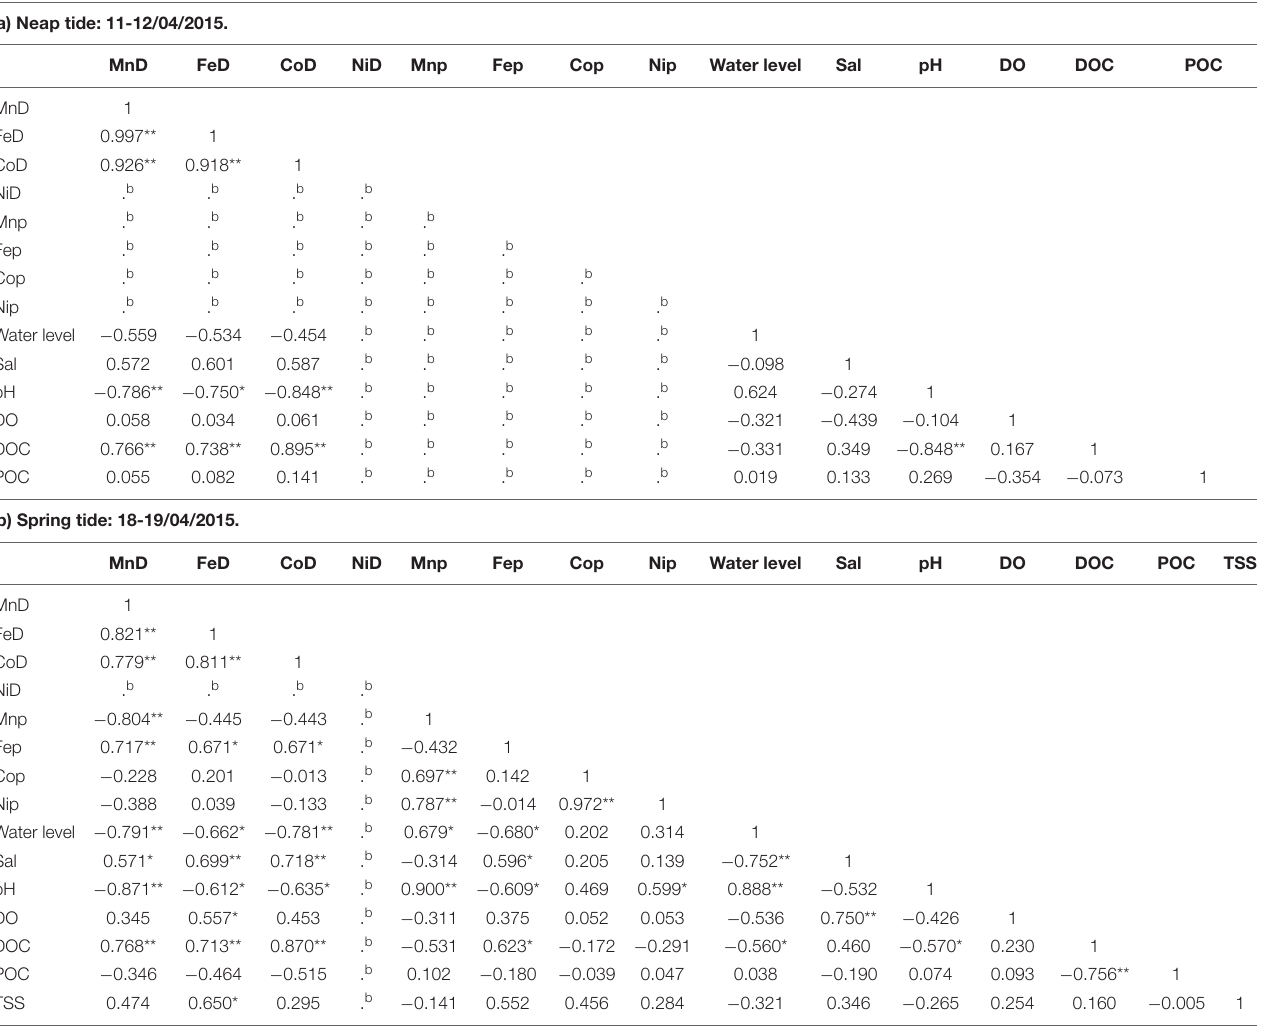
TABLE 3 | Matrix of Pearson correlation coefficients between trace metal concentrations and different physicochemical parameters in the tidal creek during the dry season. (a) Neap tide: 11-12/04/2015.